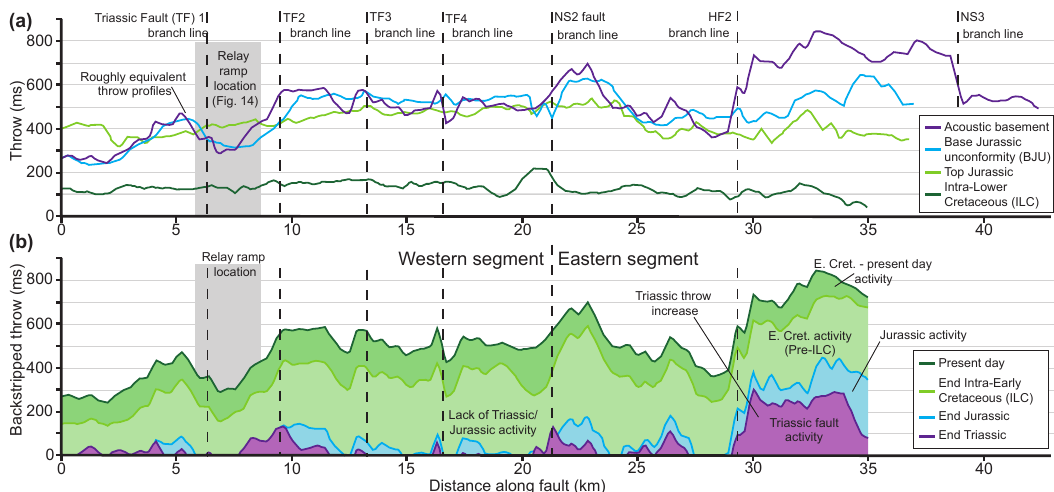
Figure 8. (a) Throw–length profiles calculated for major stratigraphic horizons across the Fjerritslev south fault showing the branch lines with cross-cutting faults. Note the similarity between the different stratigraphic horizons west of the HF2 branch line. (b) Backstripped fault profile for the Fjerritslev south fault showing Triassic activity east of the HF2 branch line but not elsewhere along the fault. Early Cretaceous fault activity is observed along the length of the